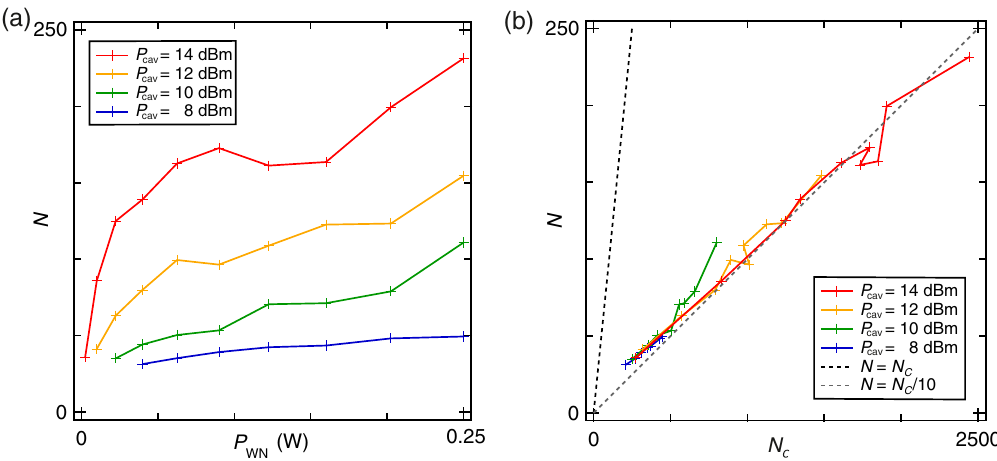
FIG. 3. (a) Accuracy N versus white-noise power P for P in the range 8 – 14 dBm. (b) Accuracy N versus the accuracy predicted WN cav from the classical model N for P in the range 8 – 14 dBm. The black dotted line is a guide to the eye showing the slope corresponding C cav to N ¼ N . The gray dotted line is chosen to approximate the slope of the displayed C